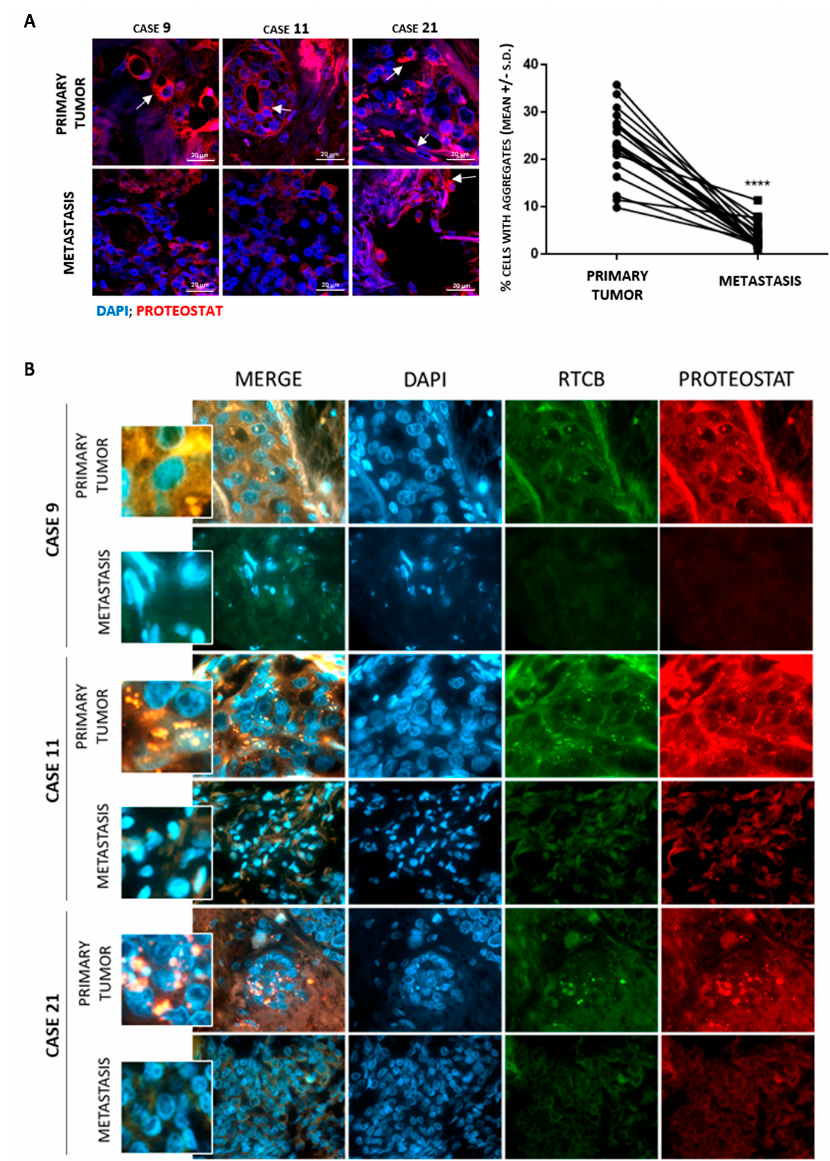
Figure 5. Protein aggregation levels and RTCB aggregation in luminal breast cancer. Human primary breast adenocarcinomas that were therapy naïve with their paired metastasis arising after completion of endocrine-therapy were analyzed by confocal microscopy. ( A ) Protein aggregation detected as aggresome accumulation using Proteostat ® . ****: p < 0.0001; Wilcoxon test for paired samples. ( B ) Representative images of Proteostat ® and RTCB co-localization.